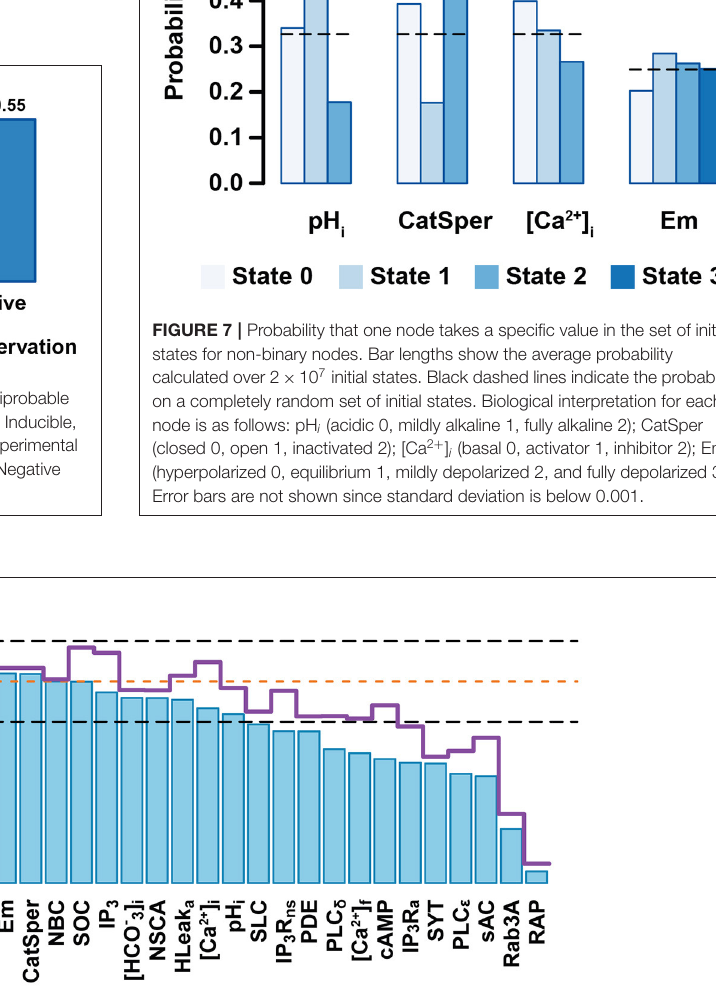
Frontiers in Physiology |